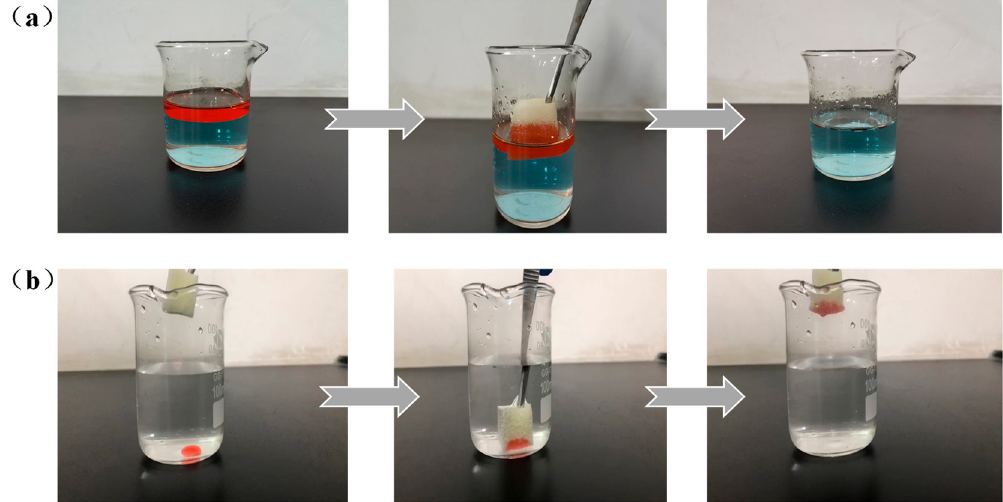
Figure 8. Selective oil absorption performance of the nano-HAp/PU sponge: ( a ) removal of diesel (dyed with oil red) below the water. ( b ) Removal of chloroform (dyed with oil red) below the water with nano-HAp/PU sponge.